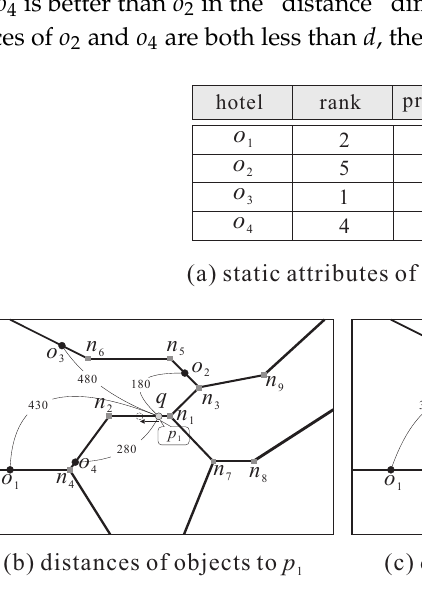
Figure 1. Example of the continuous within skyline